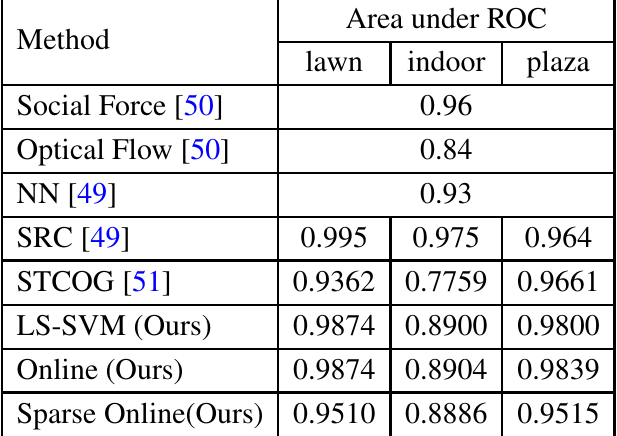
Table 3. The comparison of our proposed method with state-of-the-art methods for abnormal event detection in the UMN dataset. NN, nearest neighbor. SRC, sparse reconstruction cost. STCOG, spatial-temporal co-occurrence Gaussian mixture